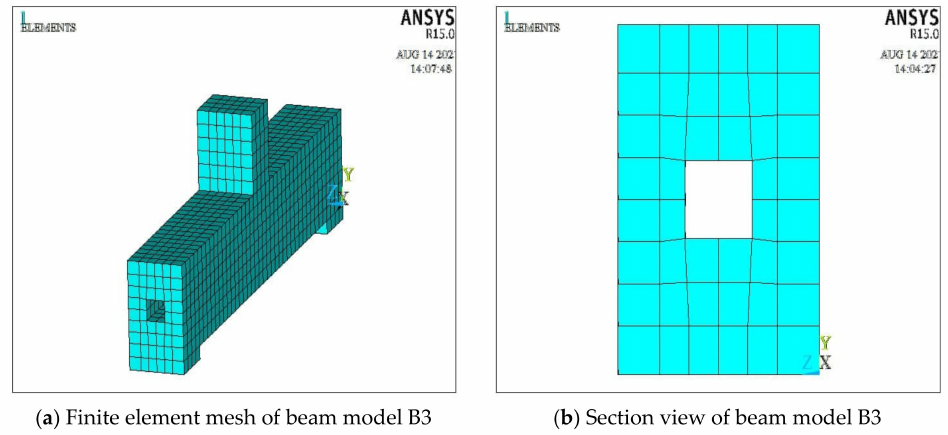
Figure 4. 3D view of beam model B3 and section view of beam model B3 with the hollow core area ratio of 7.4%.